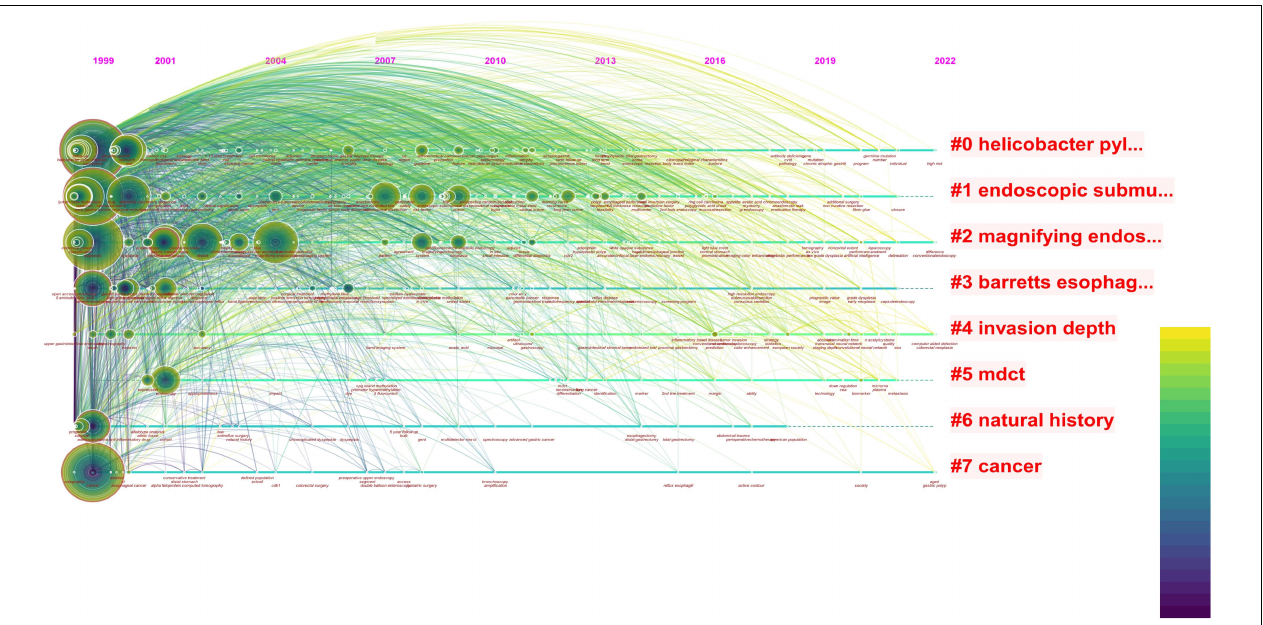
FIGURE 1 | The red font in the figure represents the keywords with the highest frequency in the included literature, the circle represents the articles published in that year, the size represents the number of articles published, and the color of the line represents the year. The reports on endoscopy and EGC were mainly concentrated between 1999 and 2010, with less and less relevant literature published in this field after that point. In the last decade, the topic of combining endoscopy with EGC has no longer been a research topic of